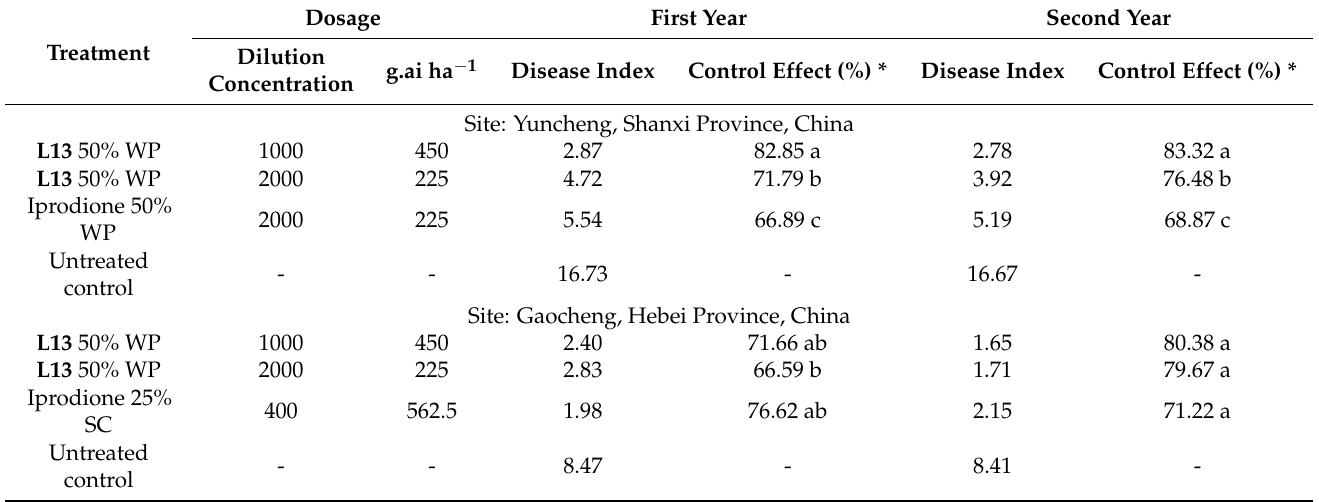
Table 3. Control effect of L13 against B. cinerea on tomatoes in field efficacy